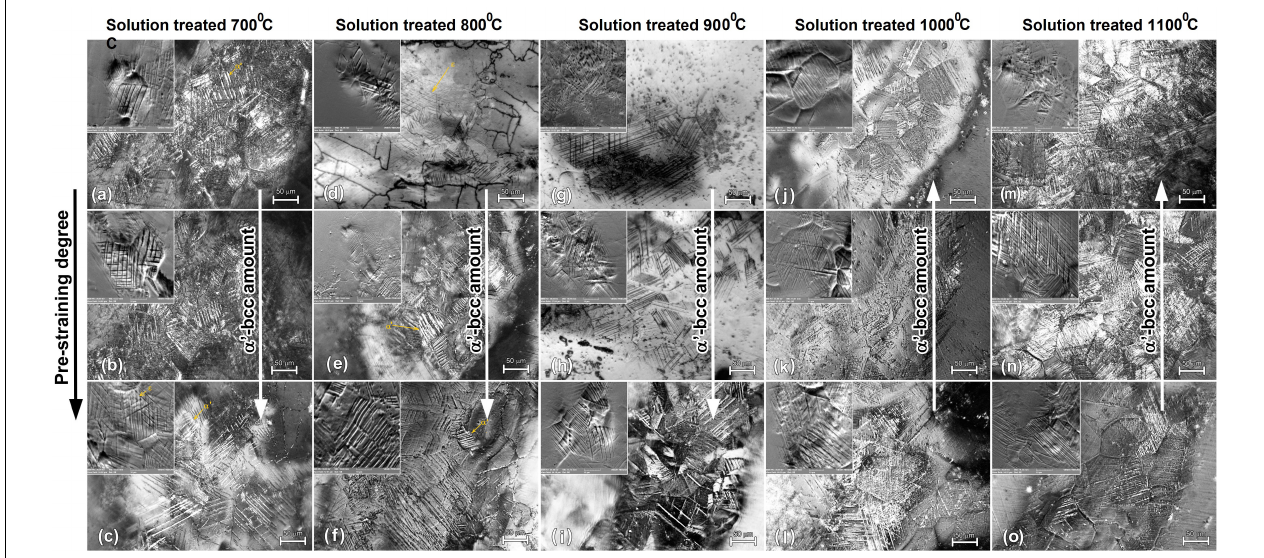
FIGURE 8 | Dark-field OM micrographs with SEM insets illustrating the formation of thermally induced martensite with increasing solution treatment temperature (from 700 to 1,100 ◦ C) and the occurrence of stress induced martensite with increasing pre-strain degree (from 0% to max. 4.2%) at specimens sintered from as-blended powders, 0_MA_700 at (a) 0%; (b) 0.7%; (c) 2%; 0_MA_800 at: (d) 0%; (e) 2.1%; (f) 3.3%; 0_MA_900 at: (g) 0%; (h) 1.8%; (i) 3.4%; 0_MA_1000 at: (j) 0%; (k) 1.7%; (l) 4.2%; 0_MA_1100 at: (m) 0%; (n) 1.1%; (o) 3.8% (reproduced after Pricop et al., 2015b, Open